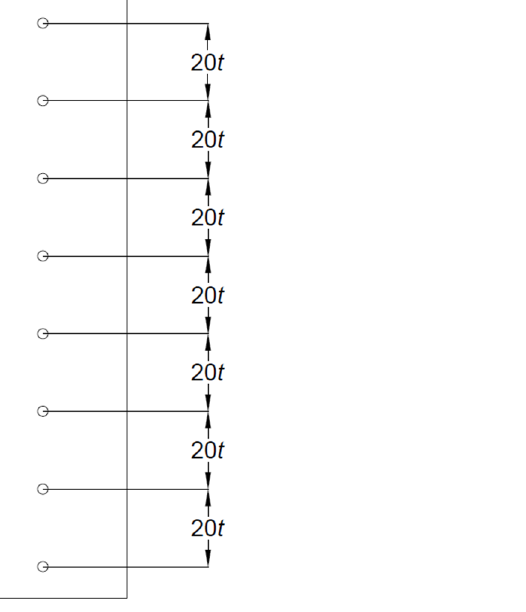
Figure 6. Side view of the column with a weld spacing of 20t.